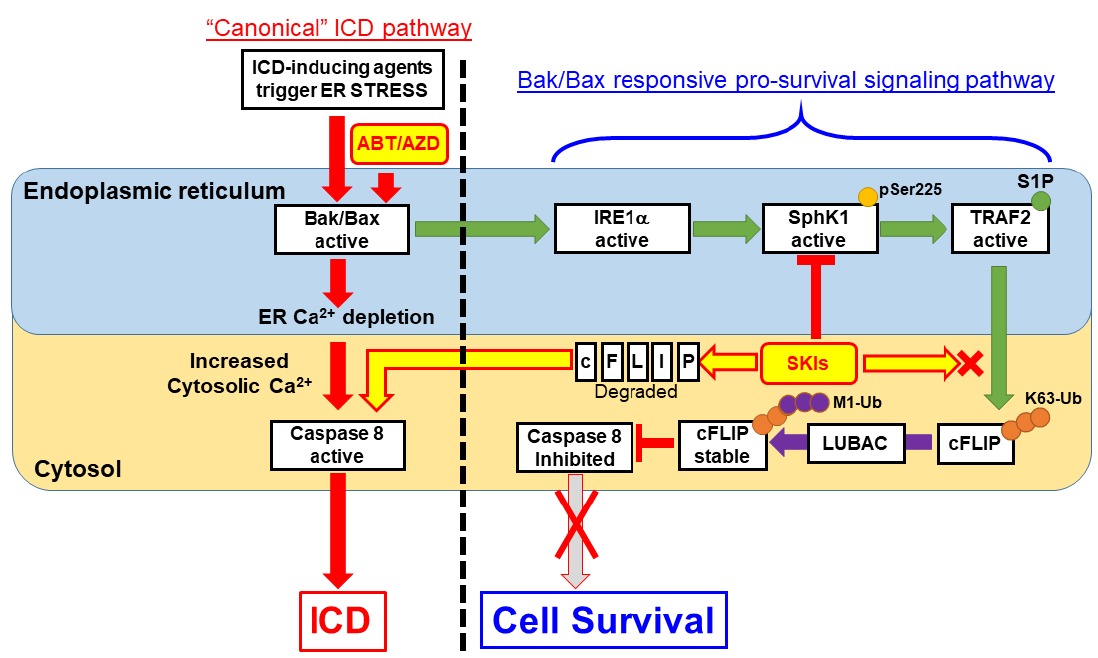
Figure 10. Proposed Model for S1P-mediated pro-survival/anti-ICD signaling. According to our results, ER membrane localized Bak/Bax activation occurs upstream of Caspase 8 activation within the “canonical” ICD pathway. ABT/AZD at high concentrations can directly induce ER lumenal Ca 2+ depletion and activate Caspase 8 leading to ectoCRT exposure and ICD. At lower, non-cytotoxic concentrations of ABT/AZD, ER membrane localized Bak/Bax induced Caspase 8 activation is coun- ter- balanced by Bak/Bax induced activation of IRE1α kinase activity. IRE1α phosphorylates SphK1 at Ser225 to enhance its catalytic activity above basal levels. SphK1, localized to the cytosolic face of the ER membrane, interacts with TRAF2 and produces S1P locally to activate TRAF2 K63 ubiquitin ligase activity to polyubiquitinate c-FLIP. K63-Ub c-FLIP serves as the substrate for M1 linear ubiq-